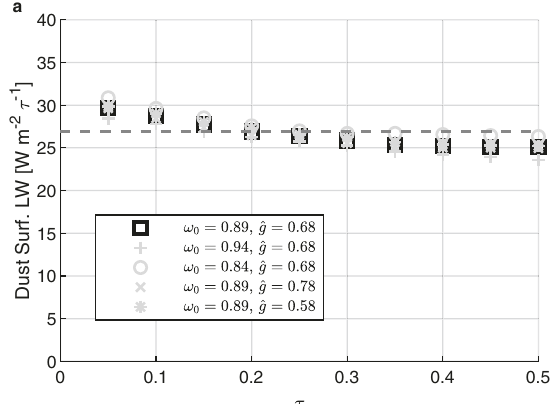
estimatefromSongetal. 86 (dashedblackline),andatthetop-of-atmosphere(TOA, bluesquares),andestimatefromSongetal. 86 (dashedblueline).Thefadedpro fi les represent the simulations with ^ g between 0.58 and 0.78 and ω 0 between 0.84 and